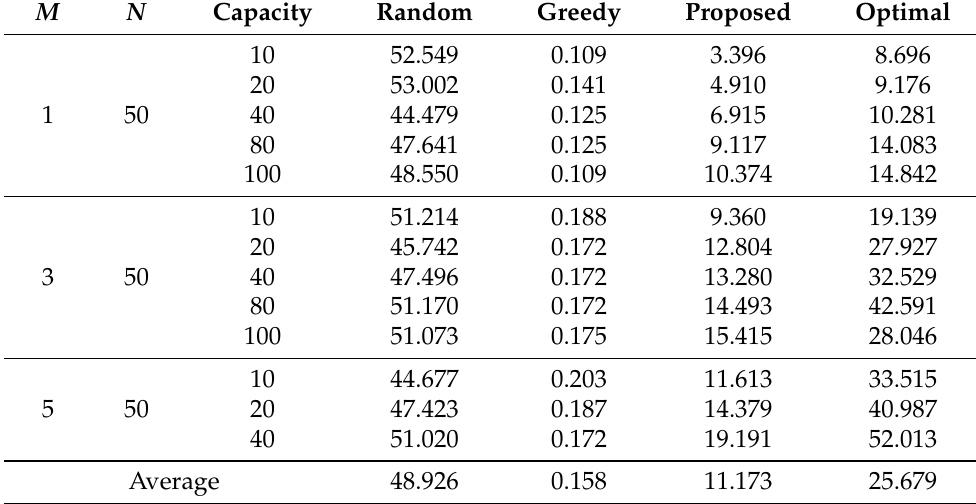
Table 14. Computation time (seconds) in LI.